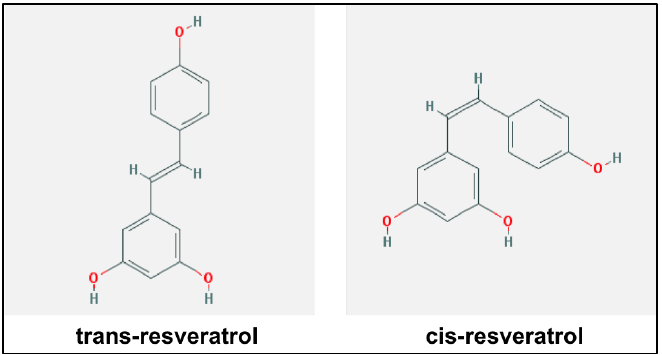
Figure 4. Bioactive conformations of Resveratrol. Chemical structures were taken from